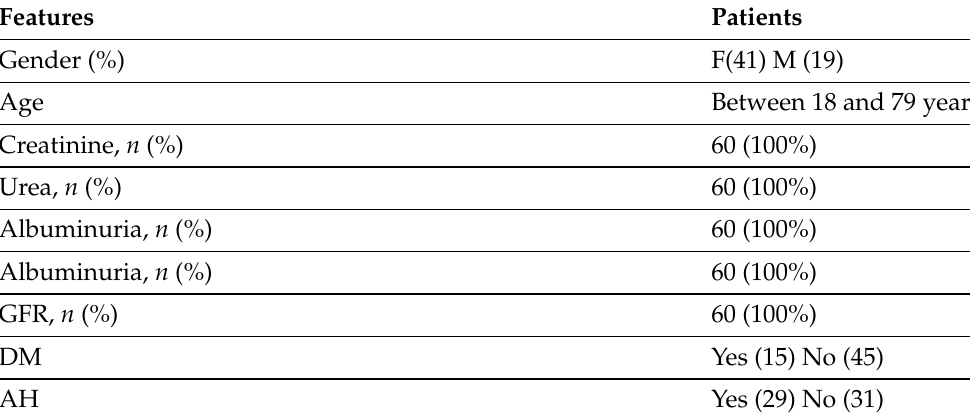
Table 2. Demographic, laboratory tests, and commodities of patients from the 60 real-world medi- cal